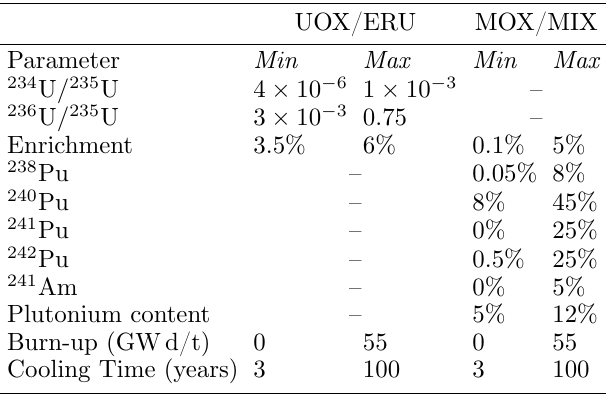
Fig. 4. Number of produced canister, regarding only decay heat or only mass, while reprocessing 100 tons of heavy metal coming from different spent UOX/ERU fuels as a function of the cooling time (in